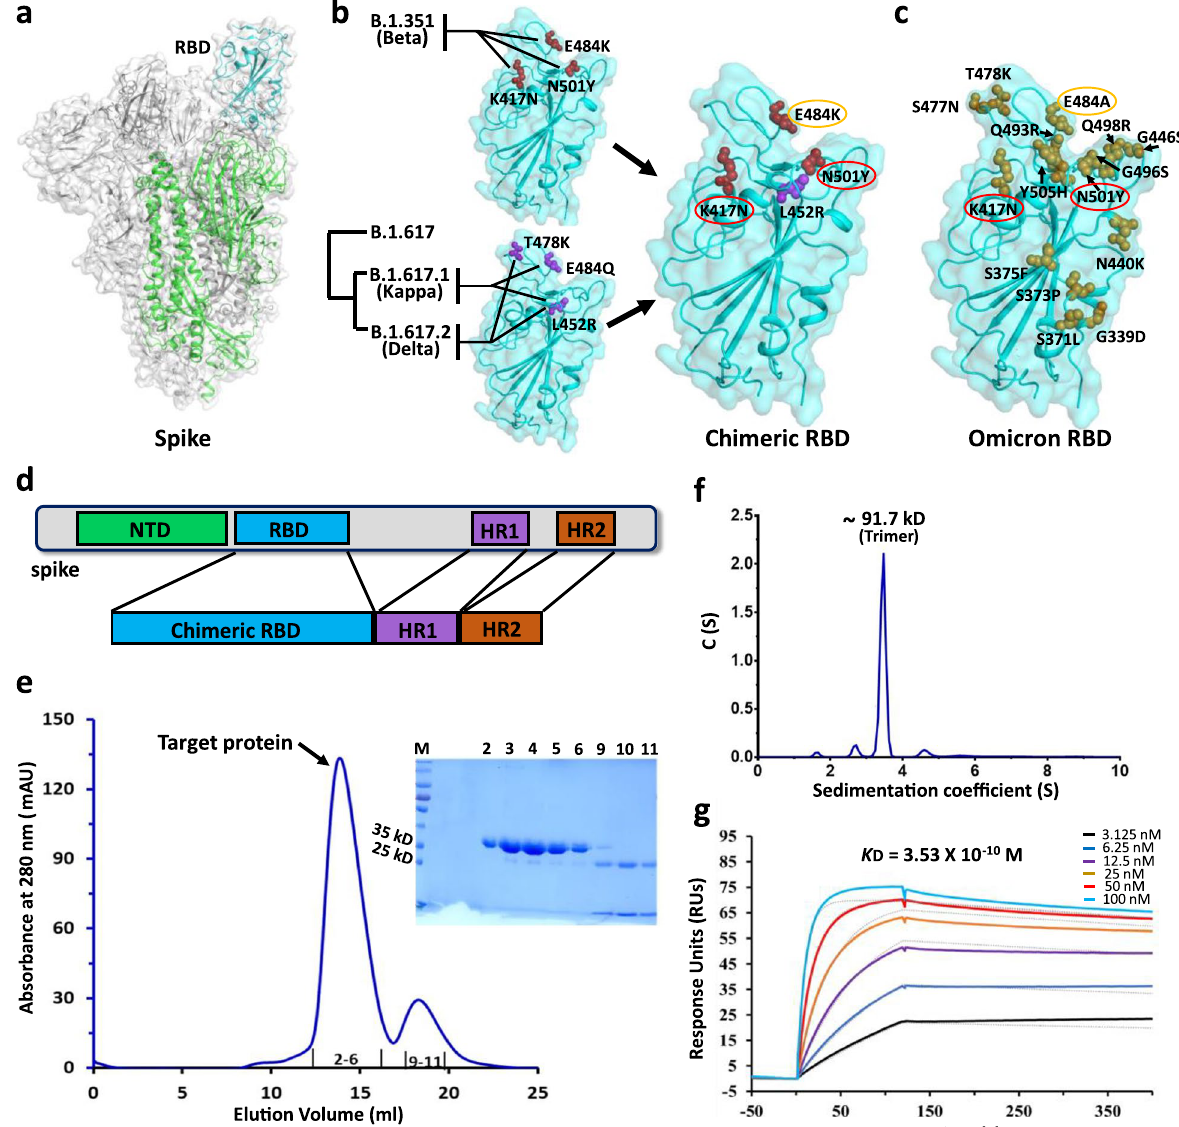
Fig. 1 Antigen design and RBD β -HR/trimer characterization. a An overview of the structure of SARS-CoV-2 spike trimer. RBD is a key component in vaccine development, which is highlighted and marked in Cyan. b An overview of our chimeric RBD design. Beta-specific substitutions of K417N, E484K and N501Y, as well as the amino acid mutation of L452R shared by the Kappa and Delta VOCs, are included to yield the final RBD design. c An overview of the residue substitutions identified in Omicron spike RBD. The K417N and N501Y mutations in our design, which are also shared by Omicron, are highlighted by encircling with red lines. The substitution of E484, by a lysine in our design but by an alanine in Omicron, is marked with yellow circles. d The chimeric RBD is further fused with SARS-CoV-2 spike HR1 and HR2 to yield the final antigen design. e The recorded solution behavior of the target protein on a Superdex 200 Increase column. The elution chromatograph of the protein and the SDS-PAGE analyses of the pooled samples are shown. f Characterization of RBD β -HR trimer with analytical ultra-centrifugation (AUC). The recorded sedimentation profiles are shown. g Characterization of the interaction between our target protein and ACE2 with surface plasmon resonance (SPR). The real-time binding profiles are